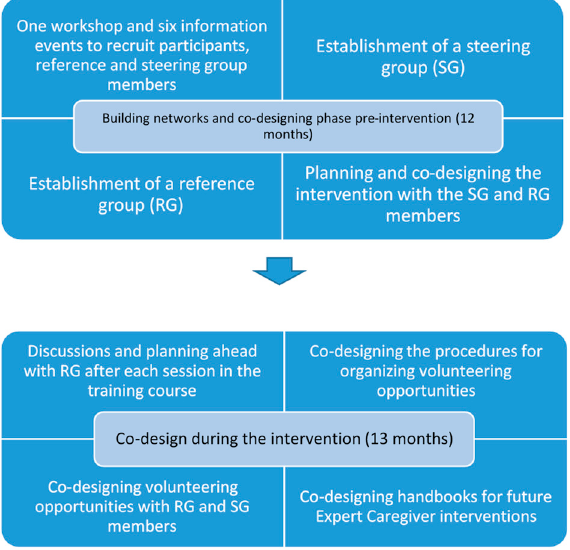
Figure 1. The co-design process.